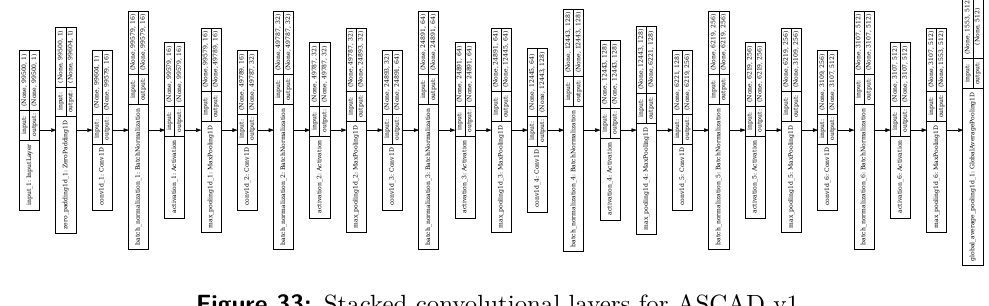
Figure 33: Stacked convolutional layers for ASCAD v1.